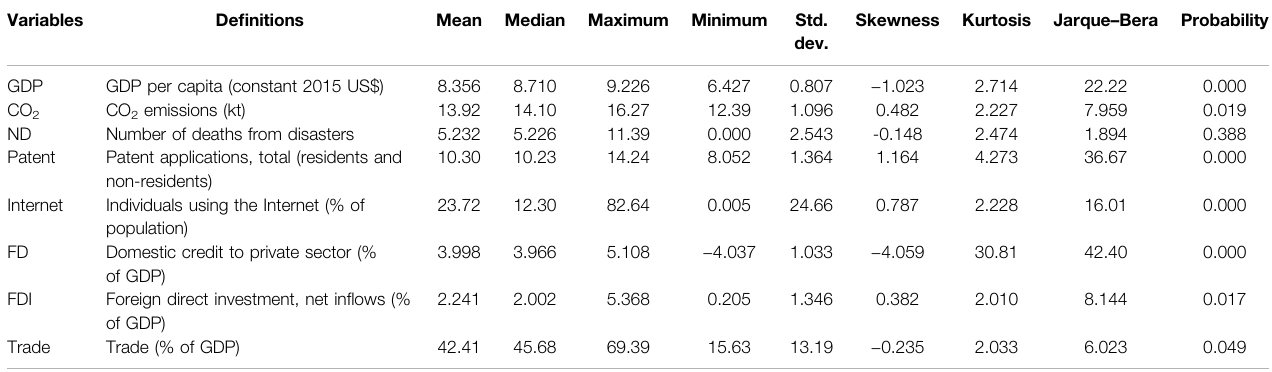
TABLE 1 | Descriptive statistics and de fi nitions.